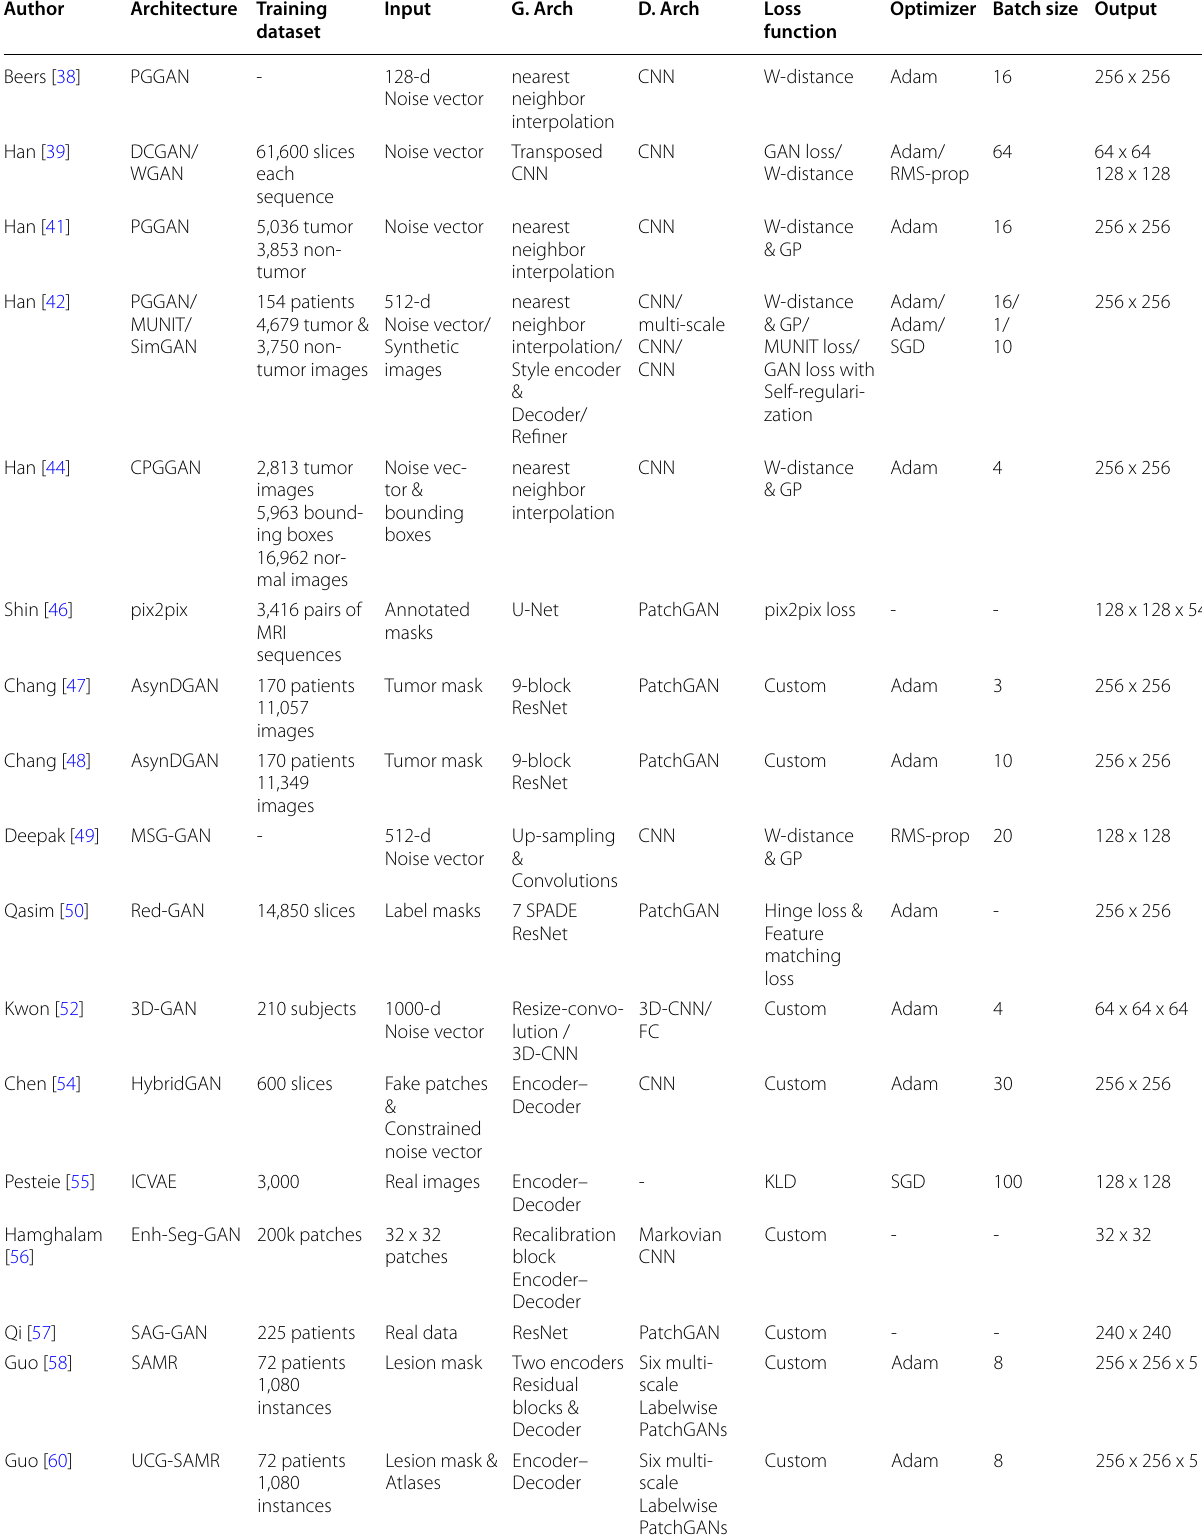
Table 2 Details in generative methodology as presented in studies for brain tumors